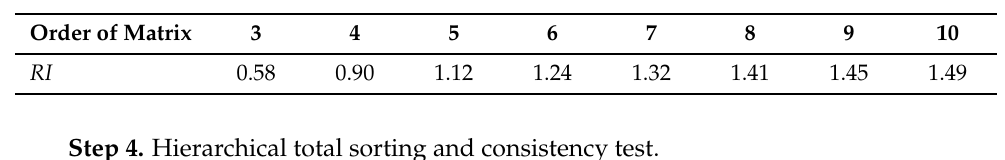
Table 2. Average random consistency ( RI